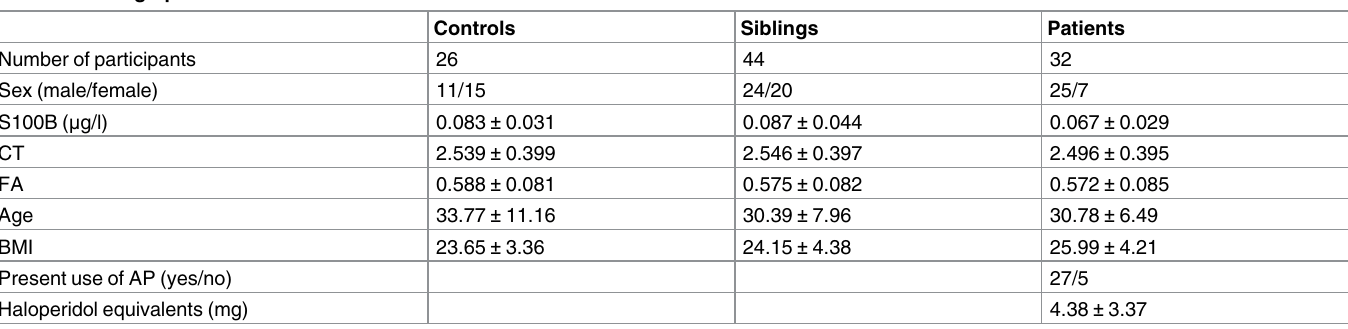
Table 1. Demographic